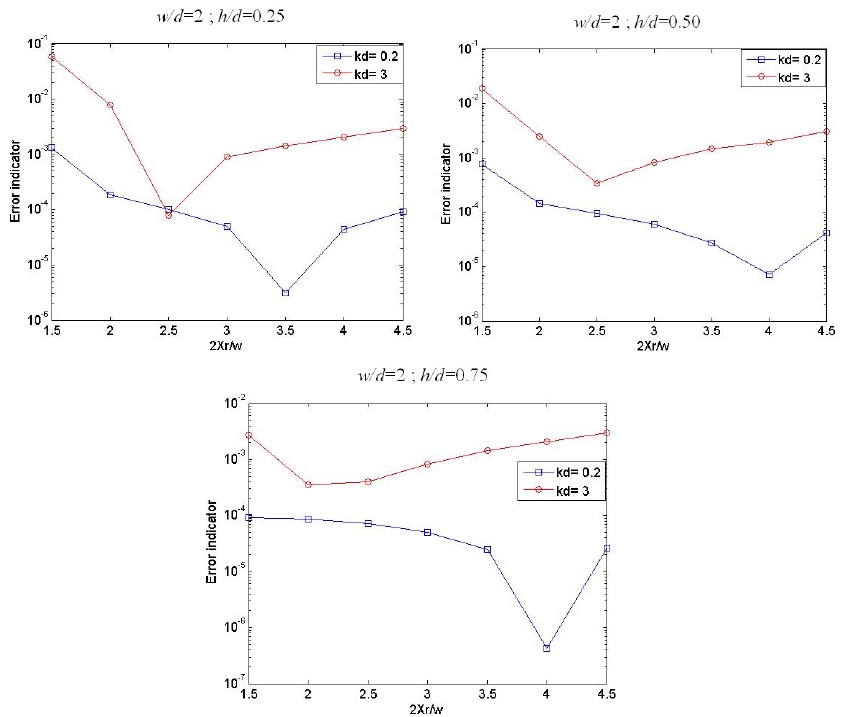
Figure 6. Error indicator versus the location of vertical fictitious boundaries for different immersion ratios.